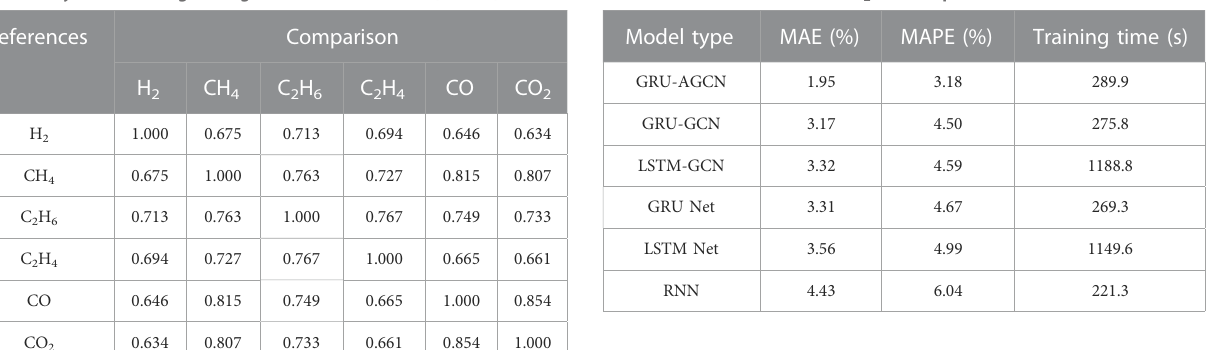
TABLE 3 Effects of models on CO 2 content